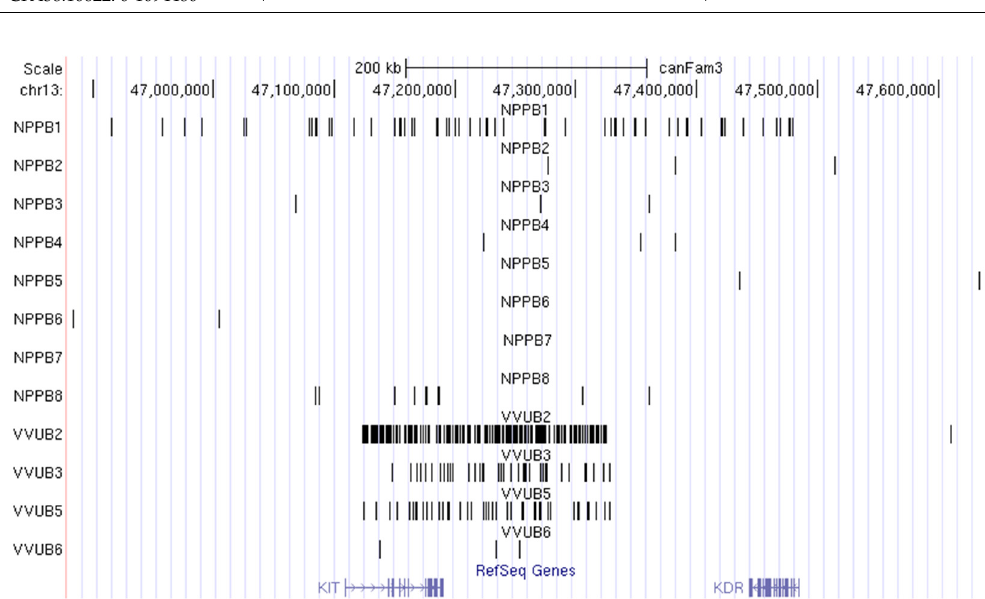
Figure 1. The region encompassing protooncogene KIT is present on B chromosomes (Bs) of the fox (VVUB2, 3, 5 and 6) and raccoon dog (NPPB1-8) visualized in UCSC genome browser (http://genome.ucsc.edu/). Coordinates are given for the dog (CanFam3.1) genome.